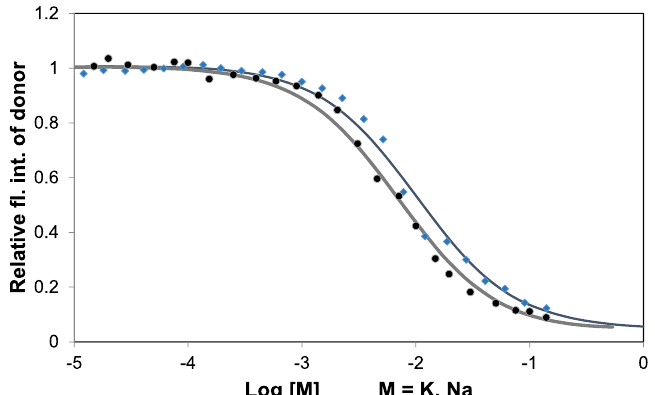
Figure 5. Relative donor fluorescence intensity of HepB as function of metal ion concentrations for Na + (filled circle) and K + (filled diamond) at 30 °C. Solid lines show the fitting to Eqs. (2) and